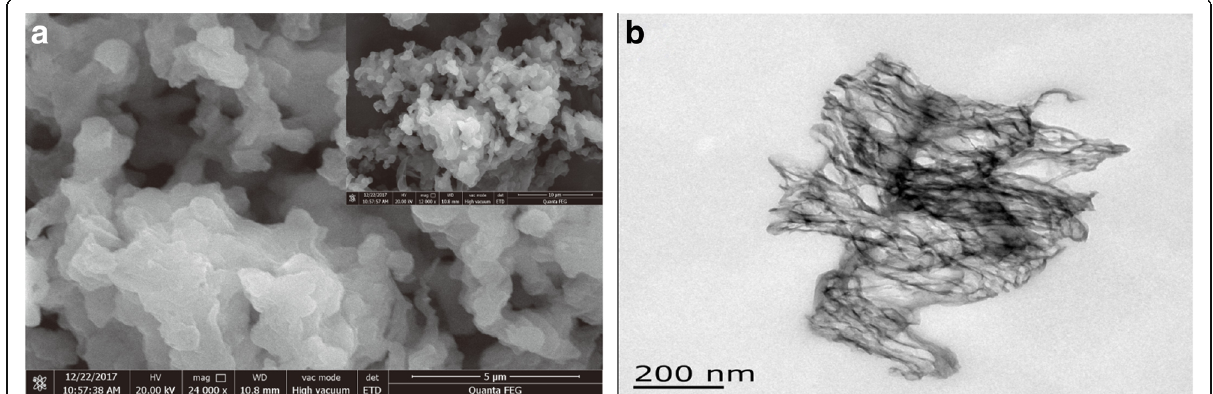
Fig. 4 a SEM and b TEM images of CN